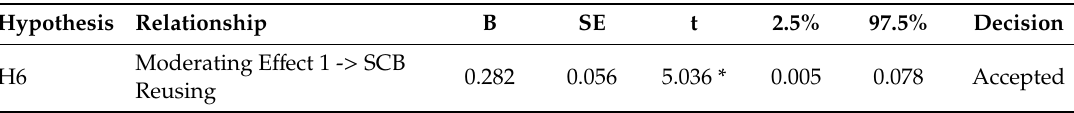
Table 6. Path coe ffi cients for direct